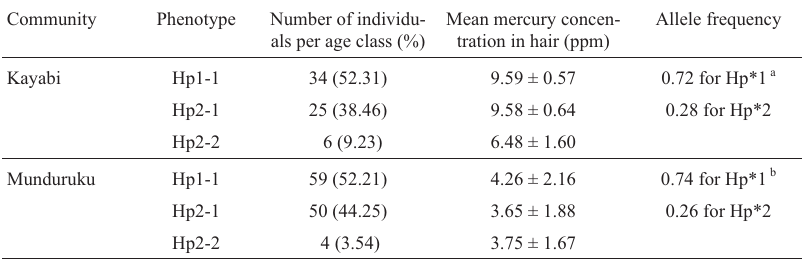
Table 2 - Relationship between haptoglobin (Hp) phenotype and mercury levels in the hair of individuals from the Kayabi and Munduruku Amerindian communities.